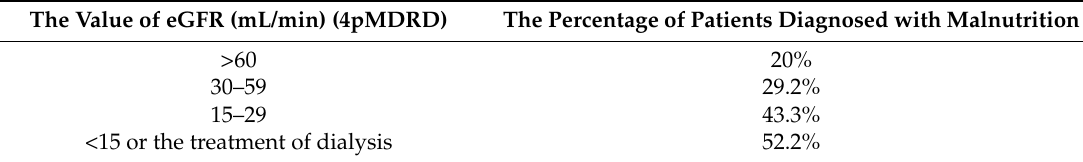
Table 3. The prevalence of malnutrition depending on the stage of CKD.